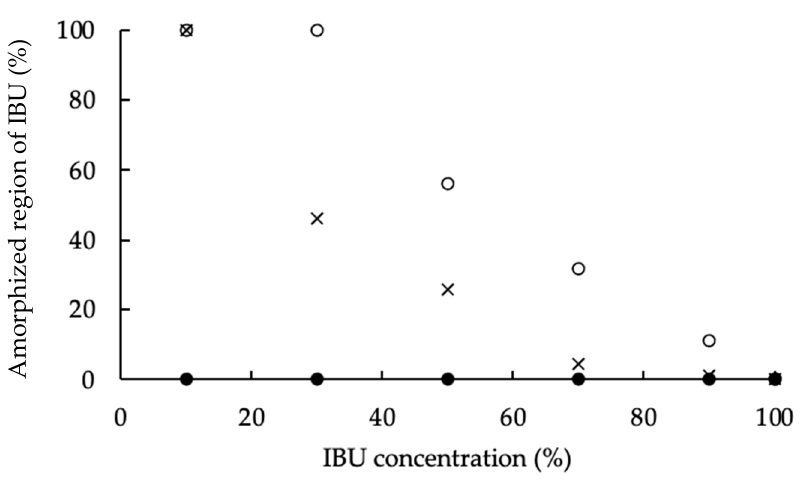
Figure 5. Percentage of the amorphized region of IBU in various samples. ○ : PS300-PMs; ×: Ca- SiO 3 -PMs; ● : ZrO 2 Beads-PMs.